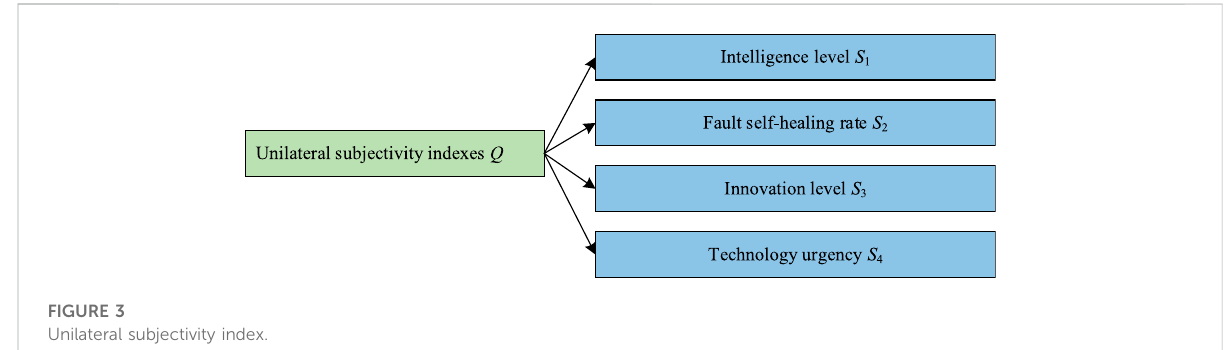
FIGURE 3 Unilateral subjectivity